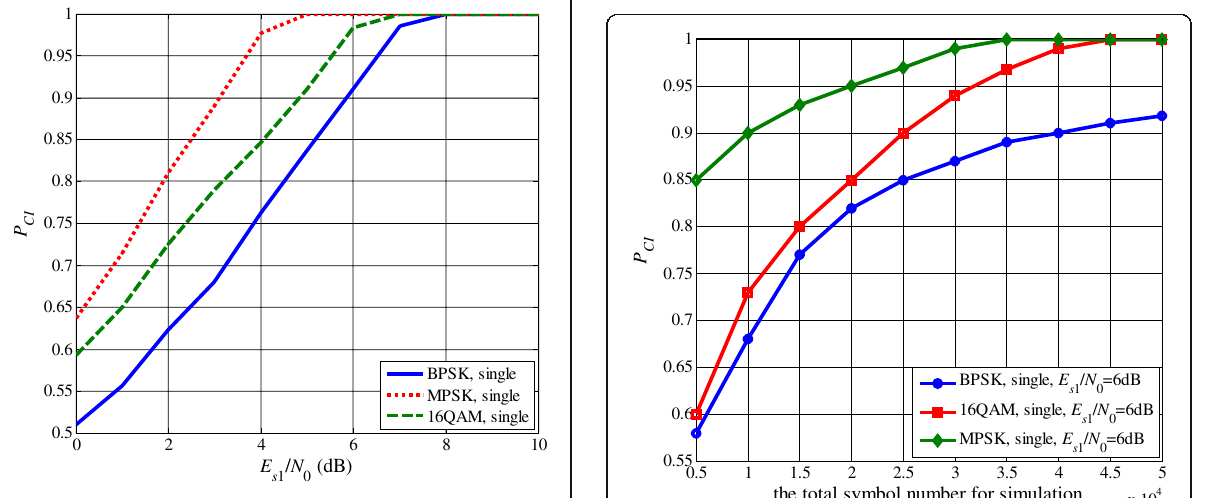
Fig. 4 The P CI as a function of the SNR for the identification of a single signal